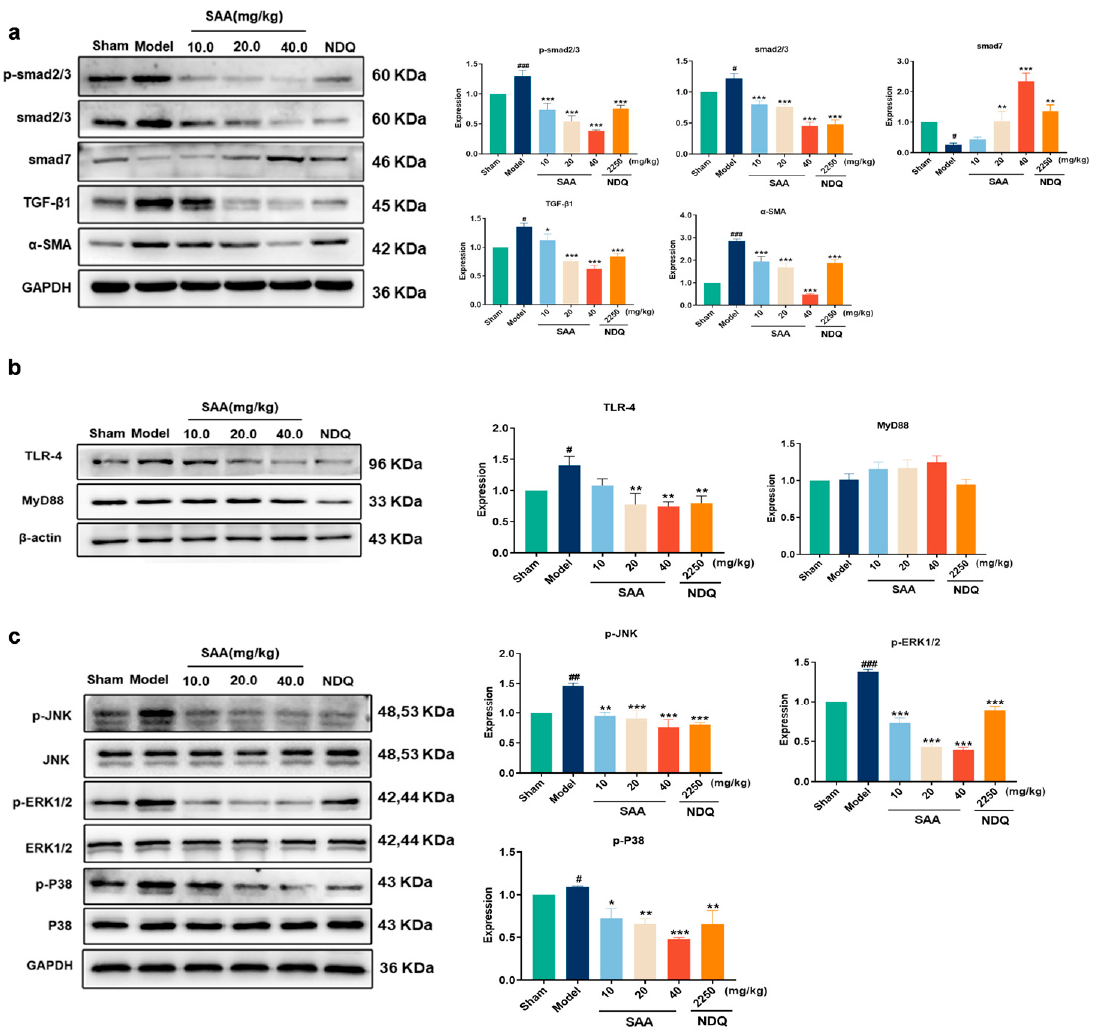
Figure 4. The effects of SAA on the expressions of TGF- β 1/smads, TLR4/MyD88 and MAPKs signaling pathways in CKD rats. ( a ) Changes in TGF- β 1/smad2/3 signaling pathway. ( b ) Changes in TLR4/MyD88 signaling pathway. ( c ) Changes in MAPKs signaling pathway. All data are shown as mean ± SEM, n = 3. # p < 0.05, ## p < 0.01, ### p < 0.001 compared with Sham group; * p < 0.05, ** p < 0.01, *** p < 0.001 compared with Model group.